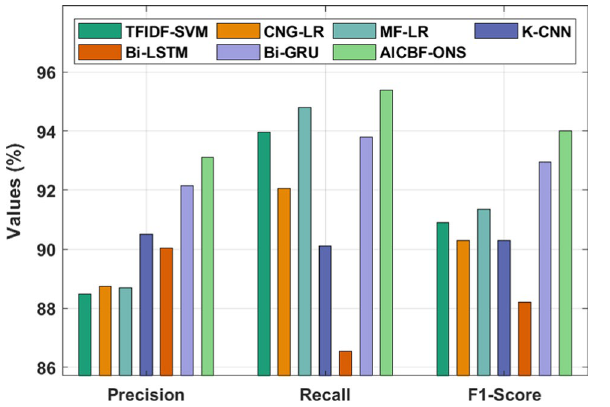
Fig. 8 Comparative analysis of AICBF-ONS model on